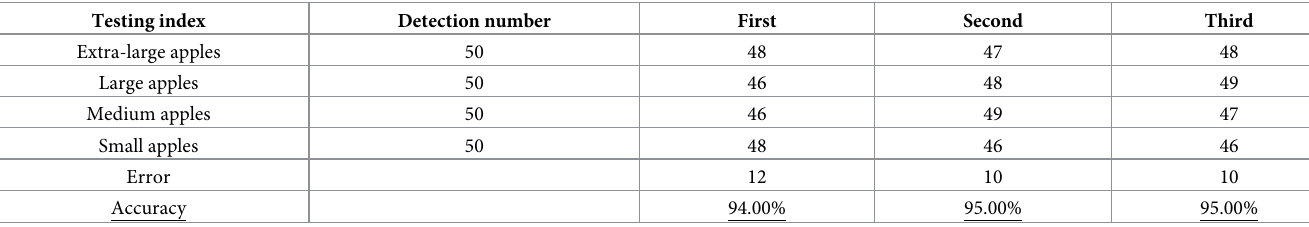
Table 3. Results of detection for apple